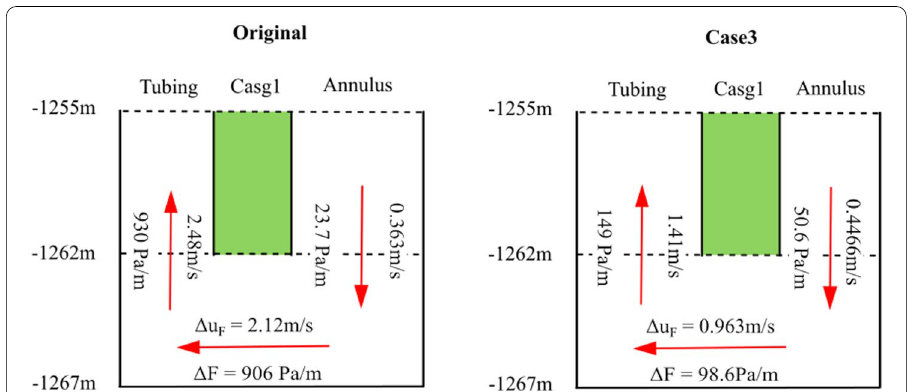
Fig. 11 Illustration for original radii and Case3 at the bottom of the well. Working fluid velocity u F and frictional pressure F values are shown for both cases. These values were extracted from the output files for connections between the bottom cell and the one above, as depicted by the red vertical arrows. The horizontal arrow is not modelled in T2Well/EOS1, but is here to represent the differences between the two cells. This image is not to